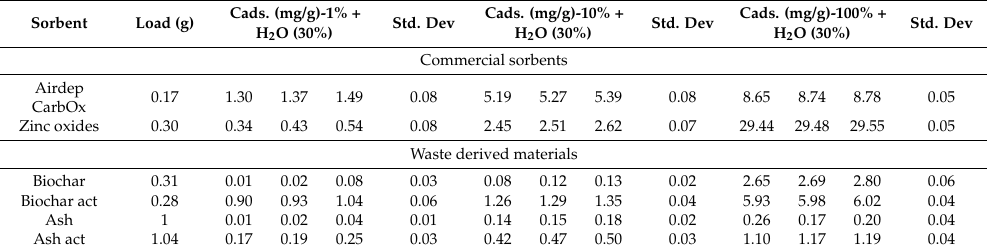
Table 4. Adsorption capacity for waste-derived materials and commercial carbons for H 2 S + H 2 O